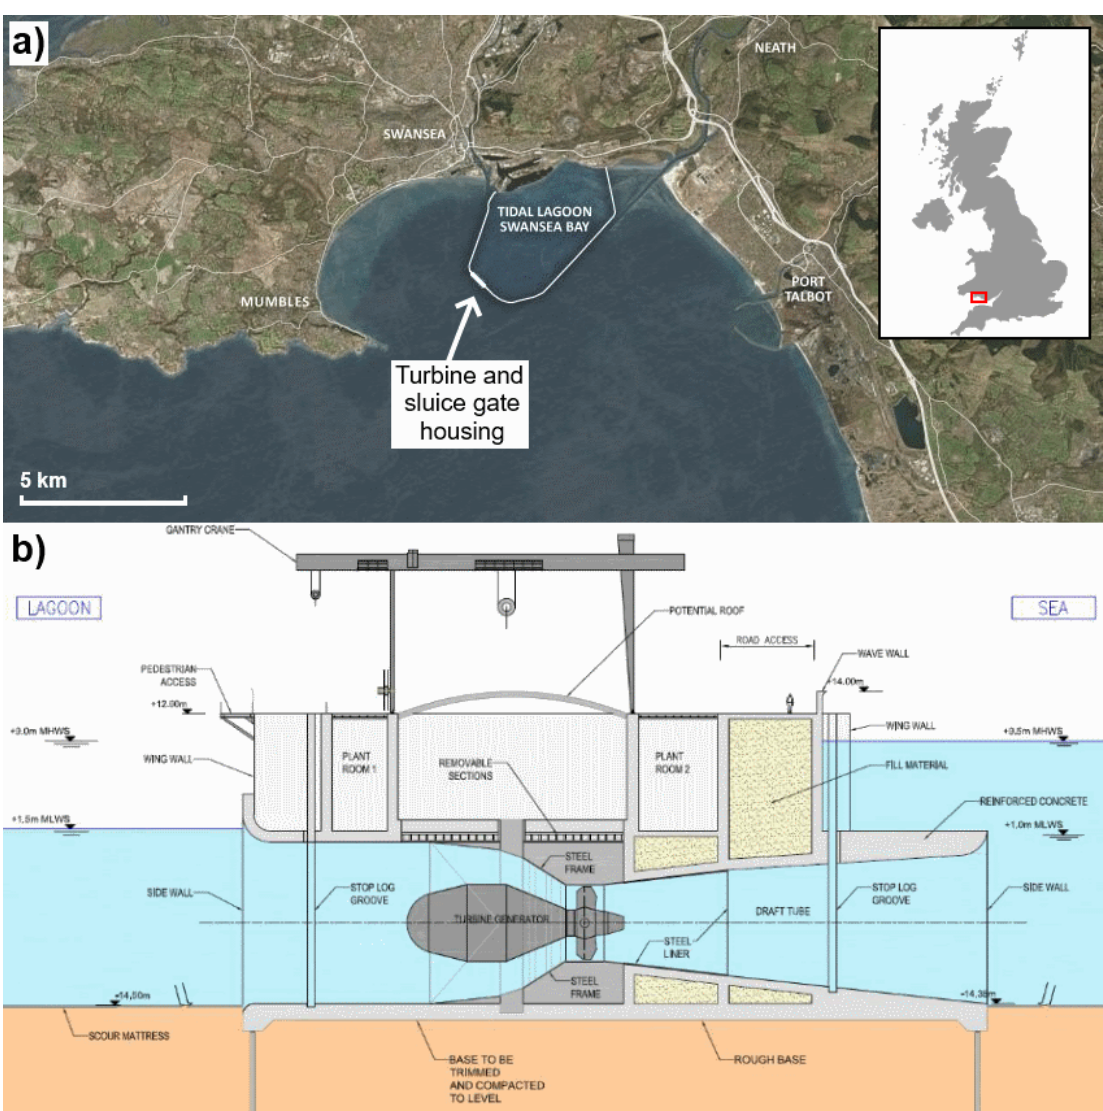
Figure 1. Location of the current lagoon proposal within Swansea Bay ( a ) and a cross-section schematic of the housing section of a bulb turbine, designed specifically for the Swansea Bay lagoon ( b ). Images courtesy of Tidal Lagoon